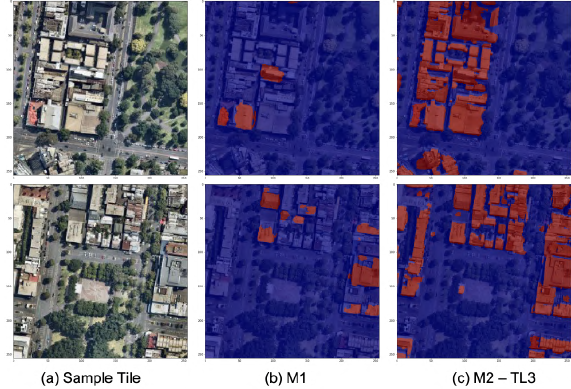
Figure 5 . Sample results from cross-validation of the base model (M1) of modified U-Net and fine-tuned model (M2) with three fine-tuning s trategies ( TL1, T L2, a nd T L3) o n t he Melbourne Building dataset (TR2).